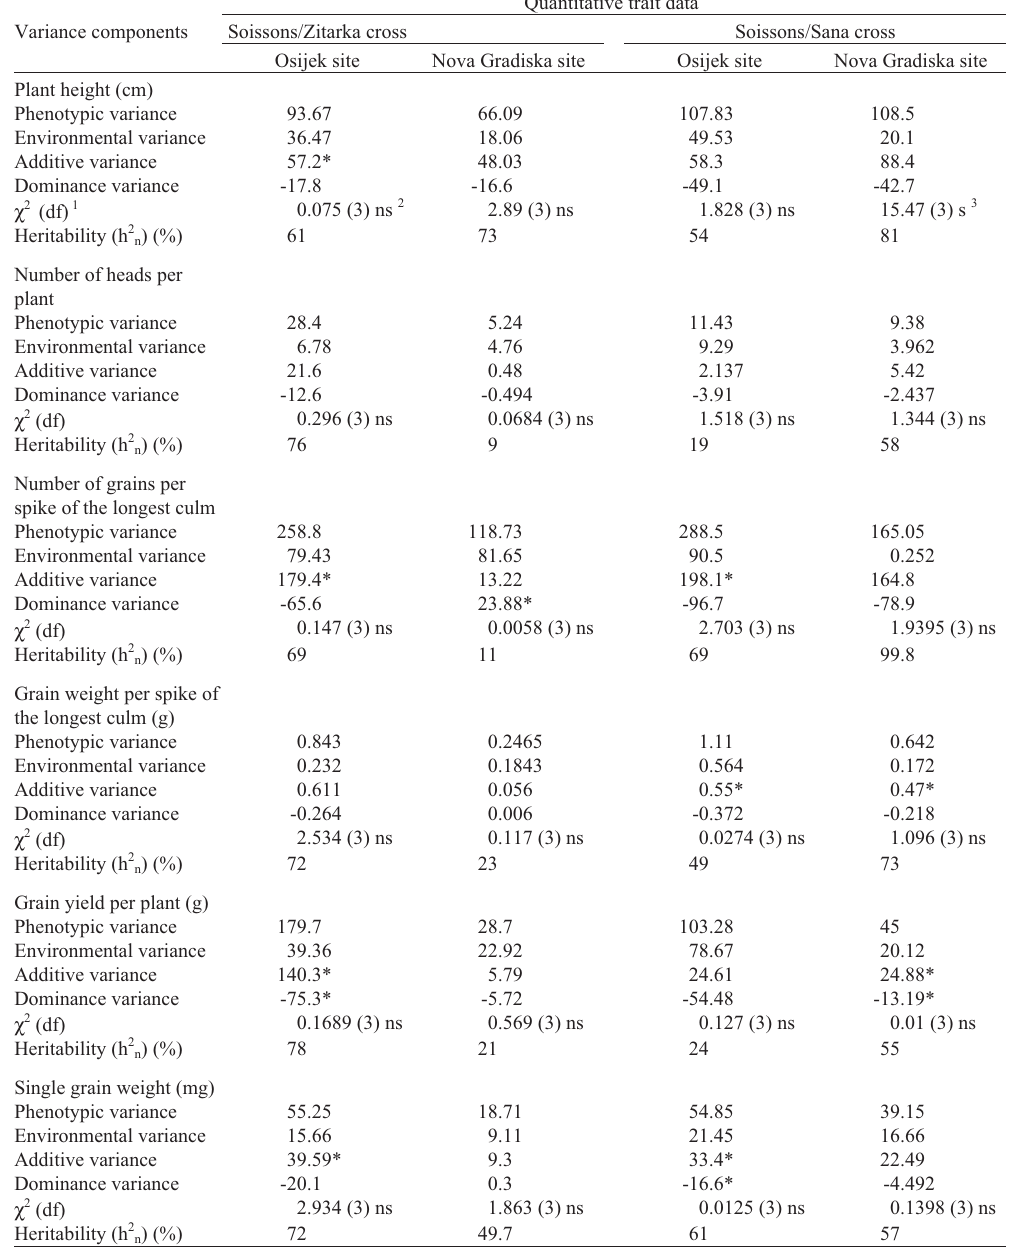
Table 4 - Estimation of variance components and narrow-sense heritability (h 2 crosses at the Osijek and Nova Gradiska